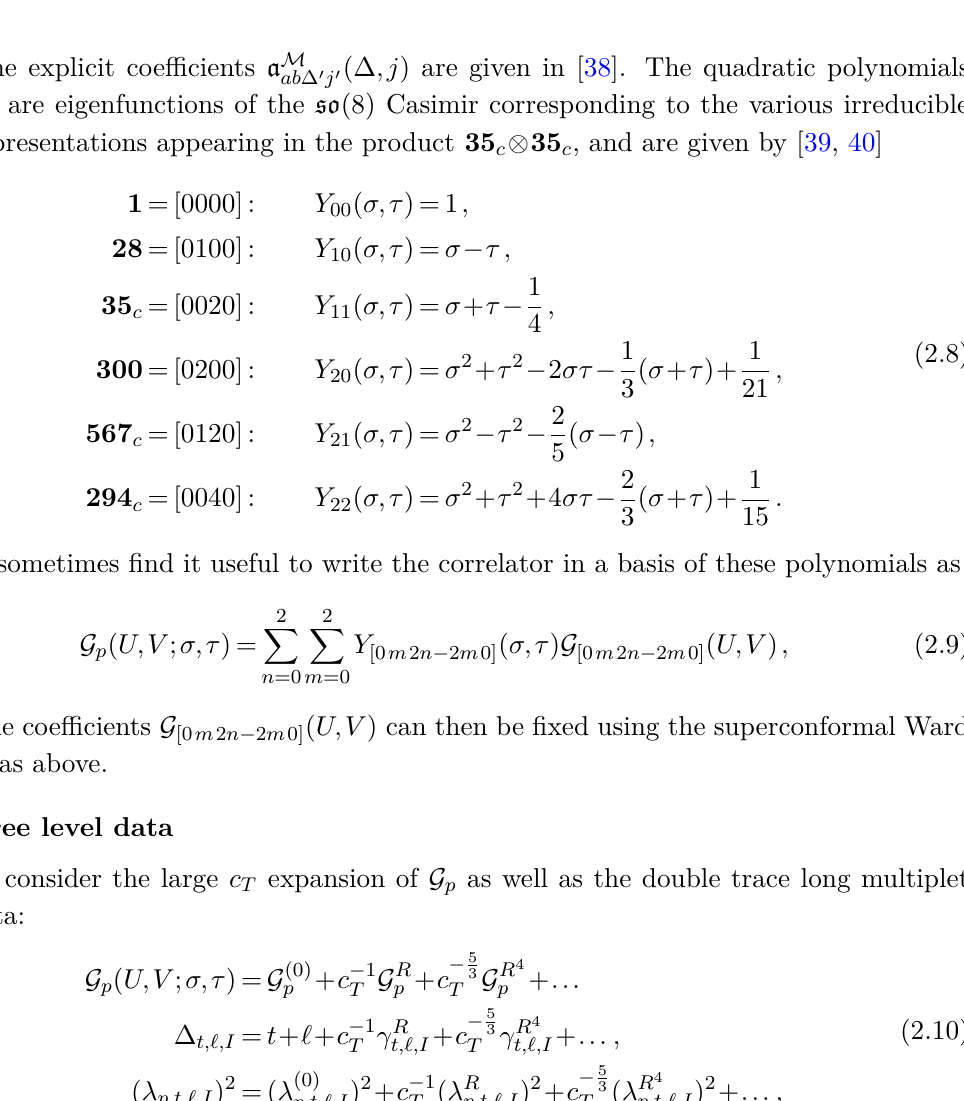
Table 1 . The possible superconformal multiplets in the S 2 × S 2 OPE. The so (3 , 2) ⊕ so (8) R quantum numbers are those of the superconformal primary in each